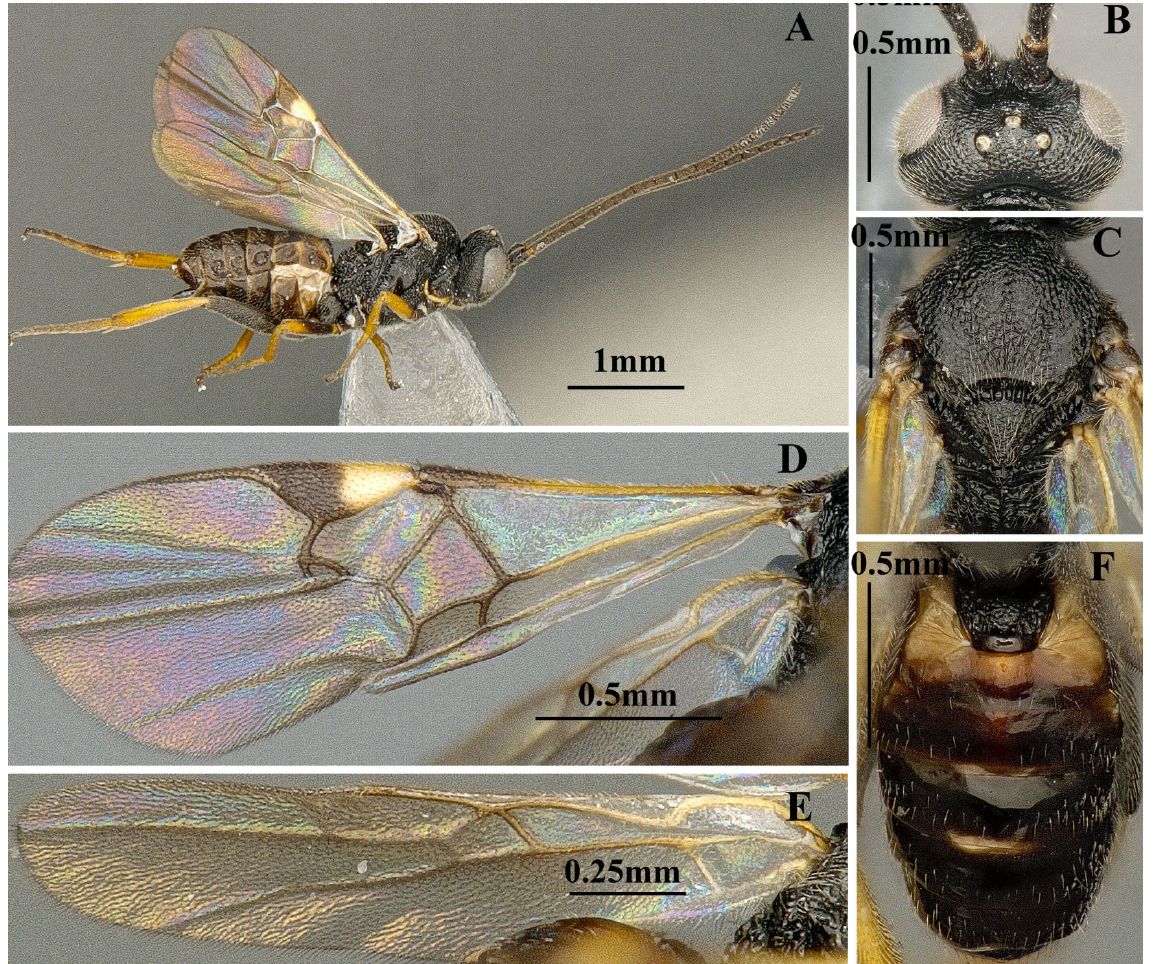
Fig. 14. Microplitis varipes (Ruthe, 1860), ♀, TMUC-HBMMP0512. A . Habitus, lateral view. B . Fore wing. C . Hind wing. D . Head, dorsal view. E . Mesosoma, dorsal view. F . Metasoma, dorsal